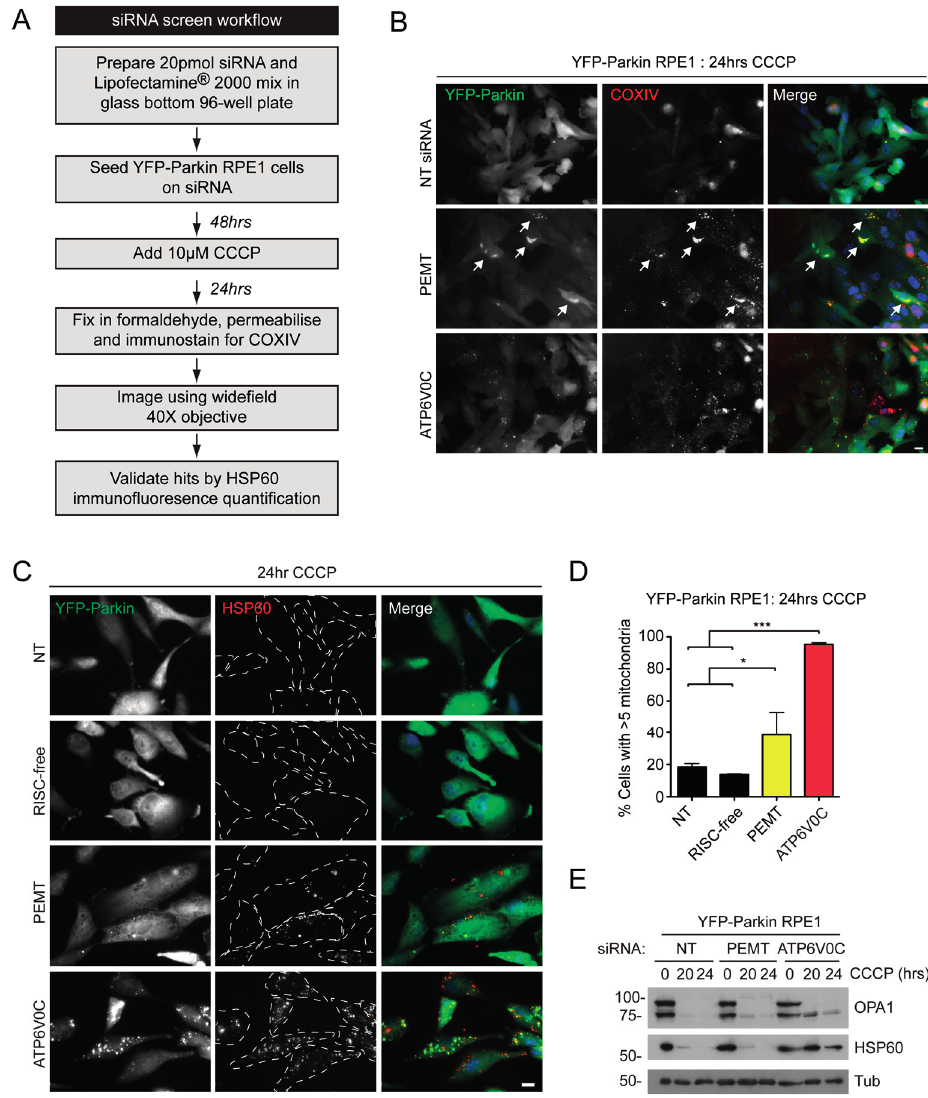
Figure 3. A mitophagy screen identifies phosphatidyl ethanolamine methyl transferase (PEMT). ( A ) Overview of the screen in YFP-Parkin RPE1 cells; ( B ) Example images of COXIV immunostained cells from the 96-well plate mitophagy screen. These examples were form the non-targeting (NT), PEMT and ATP6V0C suppressed wells. Arrows indicate cells with strong mitochondrial retention in the PEMT-treated well (Bar = 10 µm); ( C ) Examples images of mitochondrial content (HSP60 staining) in cells suppressed for the targets shown and treated with CCCP for 24 h (scale bar = 10 µm) (RISC-free siRNA is a control that is not recognized by the RNA-induced silencing complex); ( D ) Quantitation of mitochondrial retention in siRNA-suppressed cells; ( E ) Immunoblot of mitochondrial protein content (OPA1; HSP60) in cells suppressed for PEMT or ATP6V0C, treated with CCCP for the times shown. *** p < 0.001; * p < 0.05 one-way ANOVA, Tukey’s post -test. The suppression of other genes involved in the amino-glycerophospholipid biosynthetic pathway, namely PS synthase1/2 (PTDSS1/PTDSS2) and PS decarboxylase (PISD), did not reduce Parkin-mediated mitophagy (Table 1). As both PEMT and PTDSS2 can deplete PE (converting it to PC and PS, respectively) [40], siRNA oligonucleotides targeting each were combined (Figure 4A).